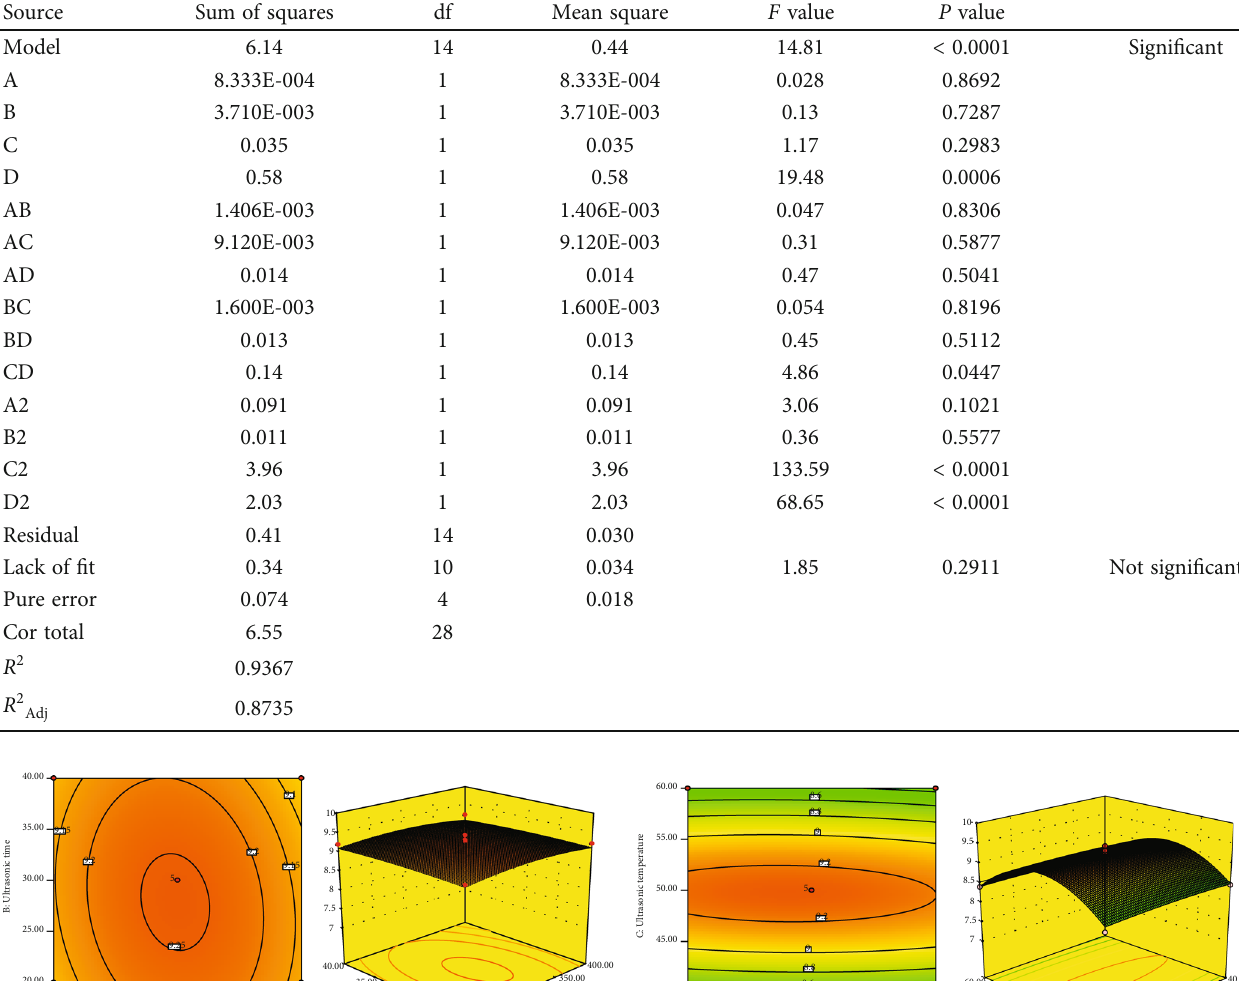
Table 6: Analysis of variance of regression model.